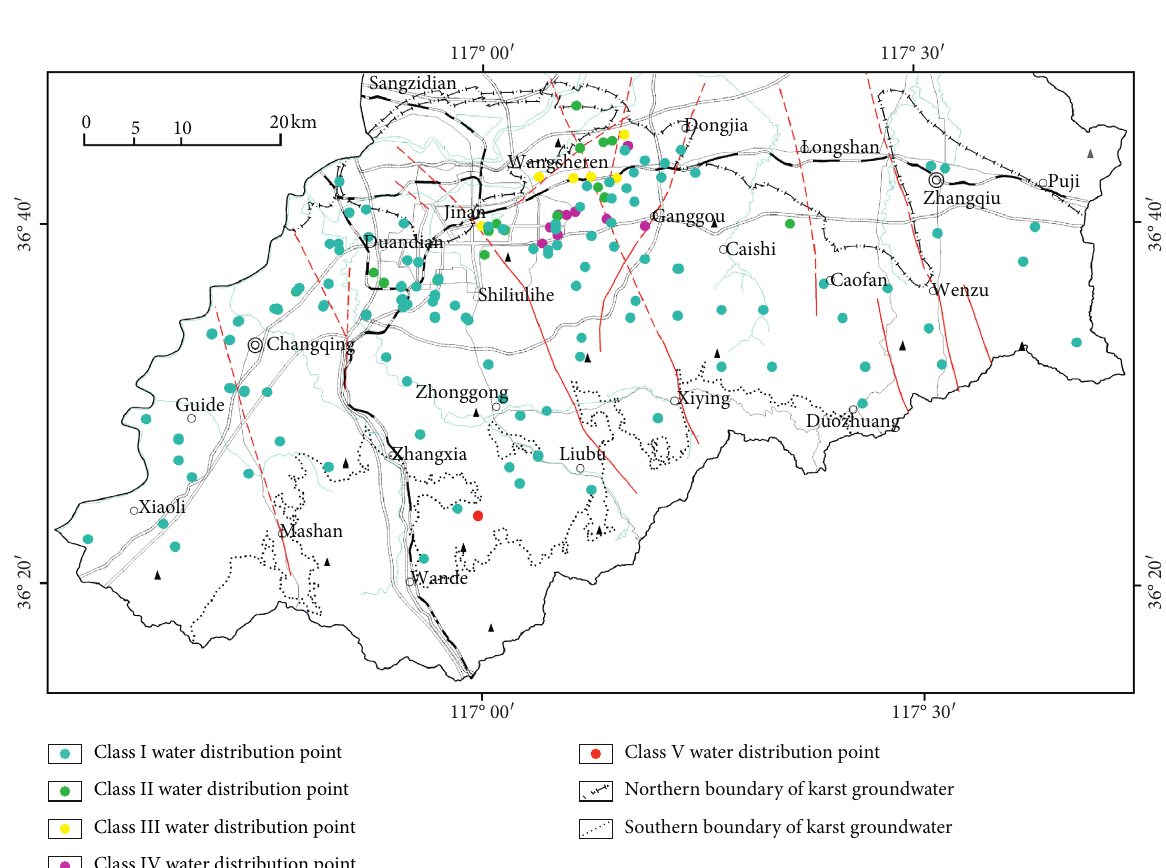
Figure 10: Quality evaluation of organic compounds of fractured karst